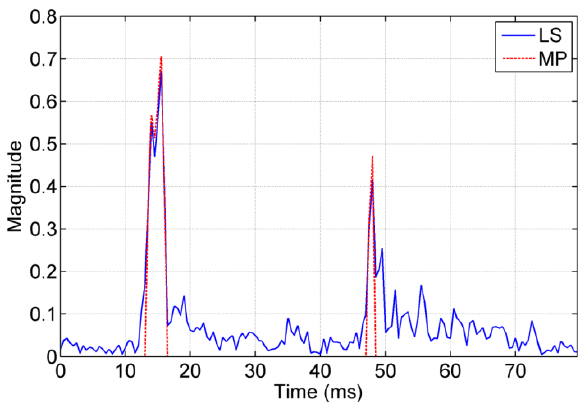
Figure 12. CIR estimated by the LS method and the MP